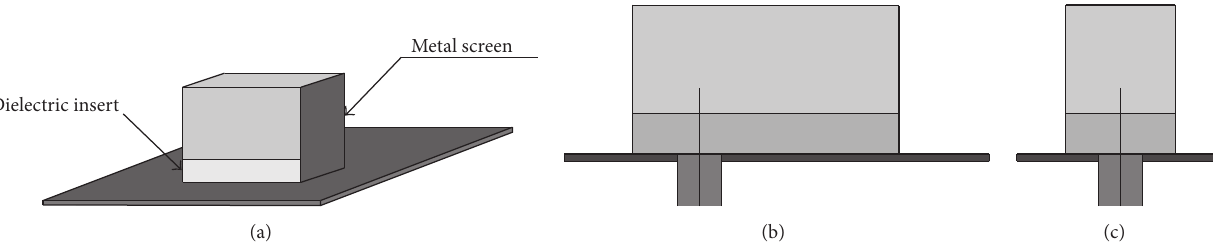
Figure 51: A compact rectangular dielectric resonator antenna with a low permittivity insert placed between the ground plane and the DR [203]. Tridimensional view (a), front view (b), and lateral view (c).